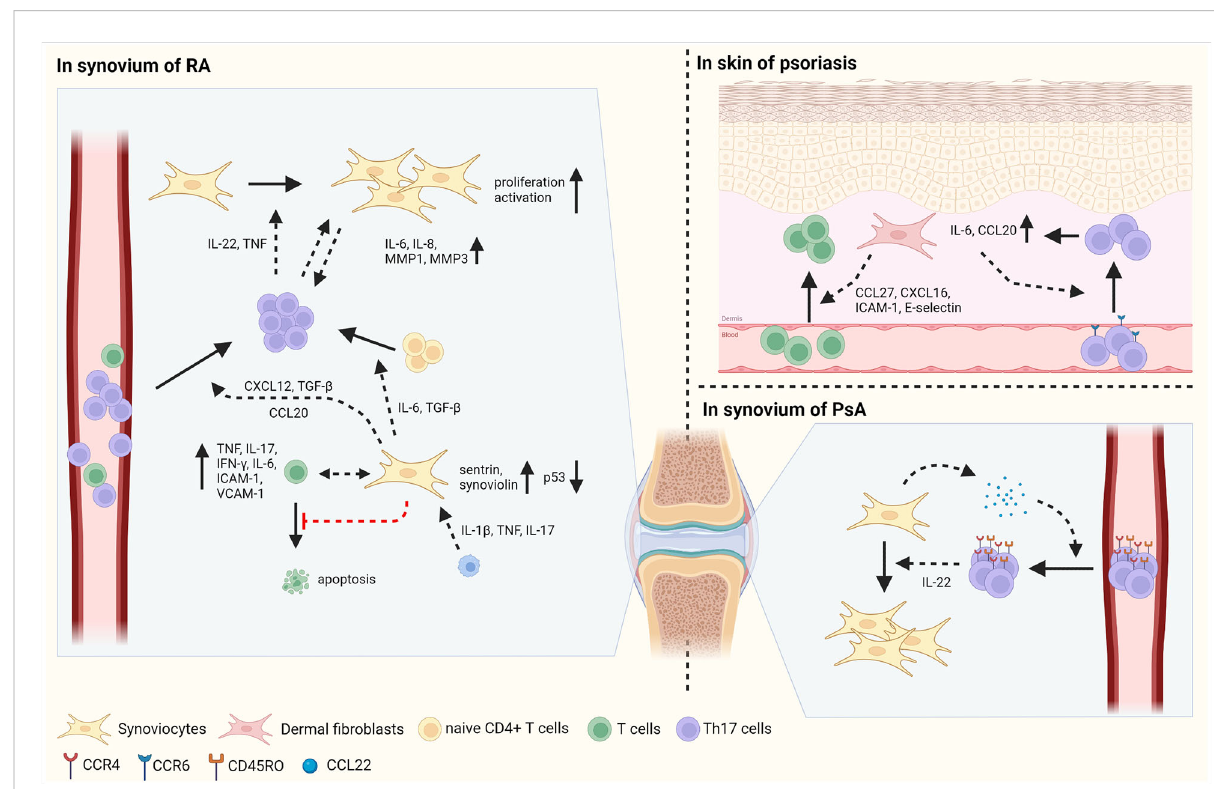
FIGURE 2 The interaction between fi broblasts and T cells in autoimmune diseases. Fibroblasts play in fl ammatory roles in autoimmune disorders such as RA, psoriasis, and PsA. In synovium of RA, synoviocytes have the mutation of p53, a tumor suppressor and increased expression of sentrin and synoviolin, which are anti-apoptotic proteins, inducing proliferation of synoviocytes. Synoviocytes elicit the differentiation of Th17 cells from naïve CD4+ T cells by IL-6 and TGF- b production. In addition, synoviocytes enhance the migration of Th17 cells via CXCL12 and TGF- b . IL-1 b , TNF and IL-17 secreted by immune cells facilitate the production of CCL20 in synoviocytes, increasing the in fi ltration of Th17 cells into synovium. In fi ltrated Th17 cells secret IL-22 and TNF, consequently improving the proliferation and activation of synoviocytes. Moreover, the contact between Th17 cells and synoviocytes induces the secretion of IL-6, IL-8, MMP-1, and MMP3 in synoviocytes. In cell-cell contact manner, synoviocytes increase the expression of TNF, IL-17, IFN- g , IL-6, ICAM-1, and VCAM-1 in activated T cells. Besides, synoviocytes suppress the apoptosis of T cells by increasing survival signals and decreasing death signals. In psoriasis, fi broblasts produce CCL27, CXCL16, ICAM-1, and E-selectin, enabling to increased migration of T cells into skin. In addition, CCL20 and IL-6 produced by fi broblasts facilitate the in fi ltration of CCR6+ Th17 cells, followed by increased expression of IL-6 and CCL20 in fi broblasts. In PsA, synoviocytes elicit the migration of CD45RO+ Th17 cells by the secretion of CCL22. Then, in fi ltrated Th17 cells promote the proliferation of synoviocytes via IL-22 production. Figure is generated with biorender